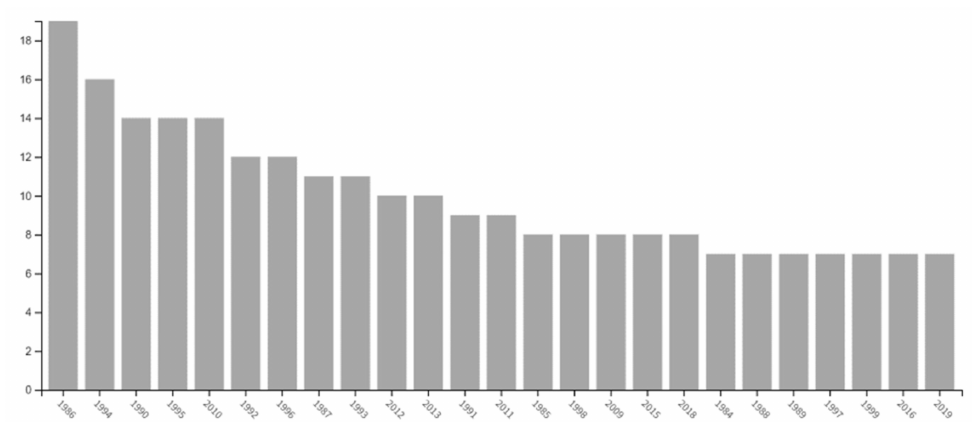
Figure 4. Results retrieved for on-topic search keywords “embryo” AND” cryopreservation” AND “social” AND “human” in the Web of Science ® Core Collection and Medline ® databases. The systematic search retrieved 303 results (all-time) with 90 published papers during the last ten years in all databases, from which we excluded books and others; 56 results were retrieved after data filtering, of which 23 were reviews, and 31 were articles. We identified four main papers focused on the EC